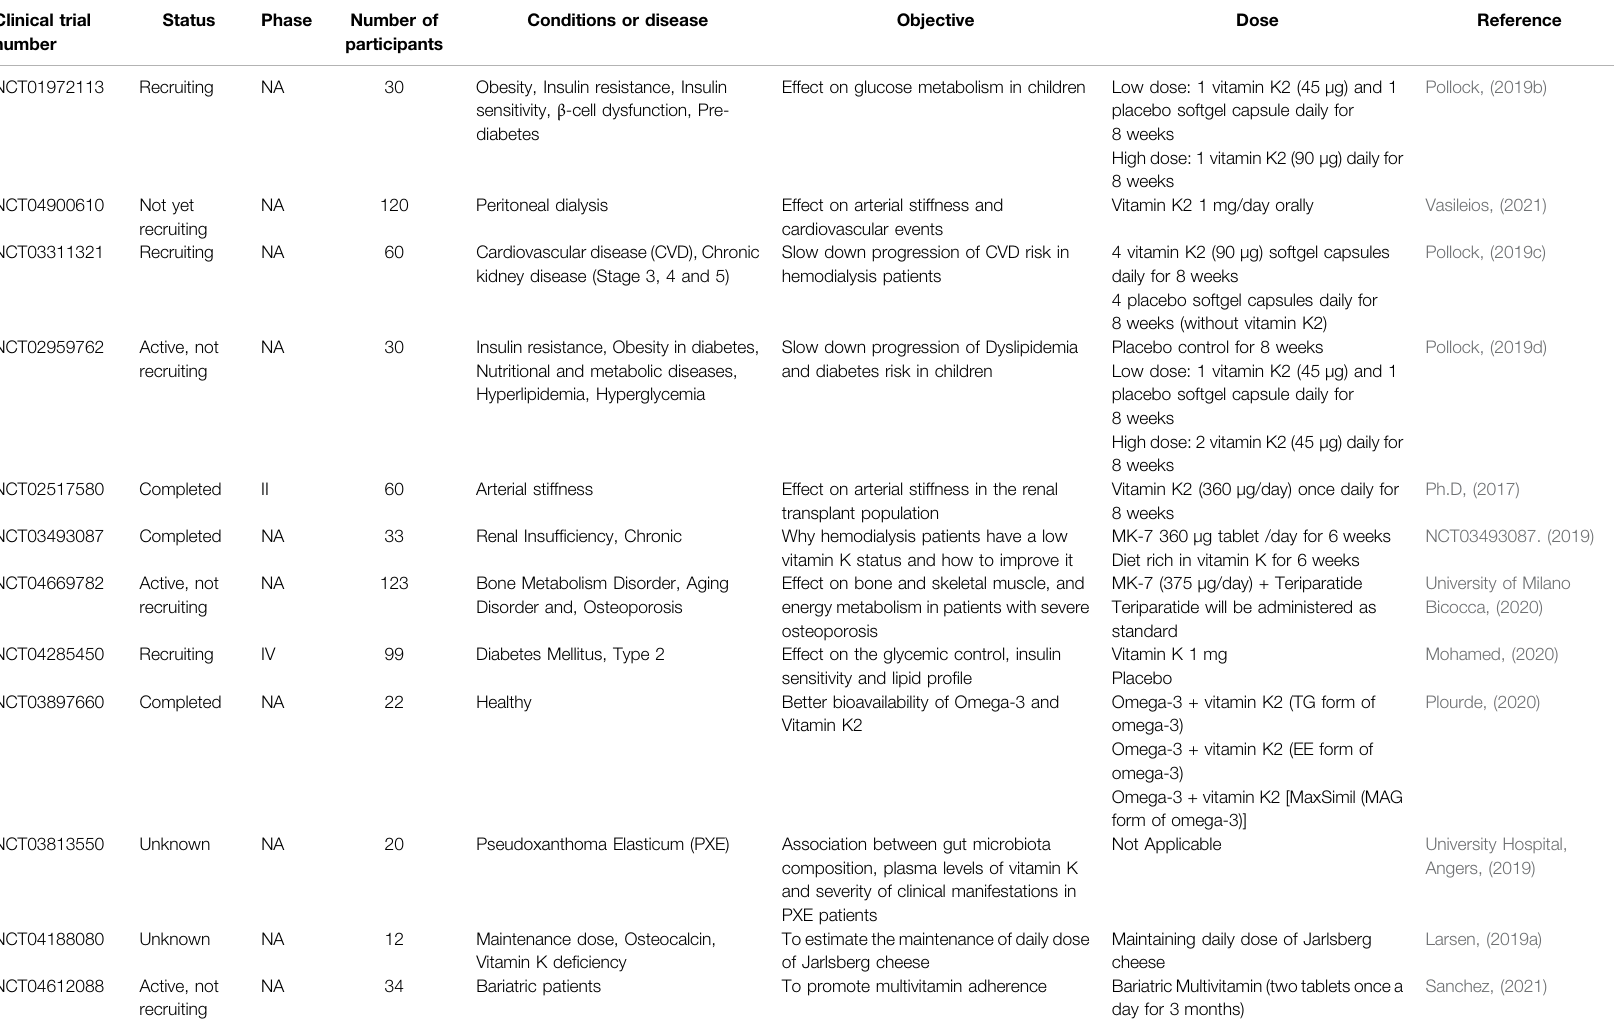
TABLE 3 | ( Continued ) Clinical trials on vitamin K2-7 in the United States of America (Adapted from